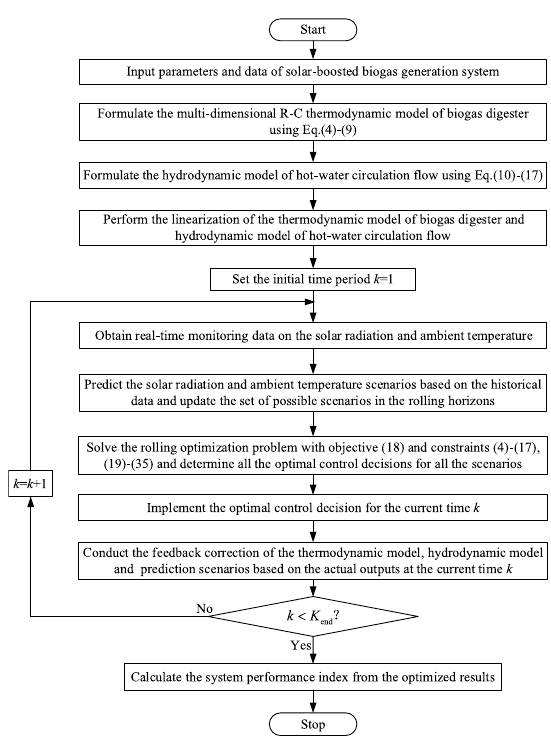
Fig. 6 Flowchart of the MPPT method solution